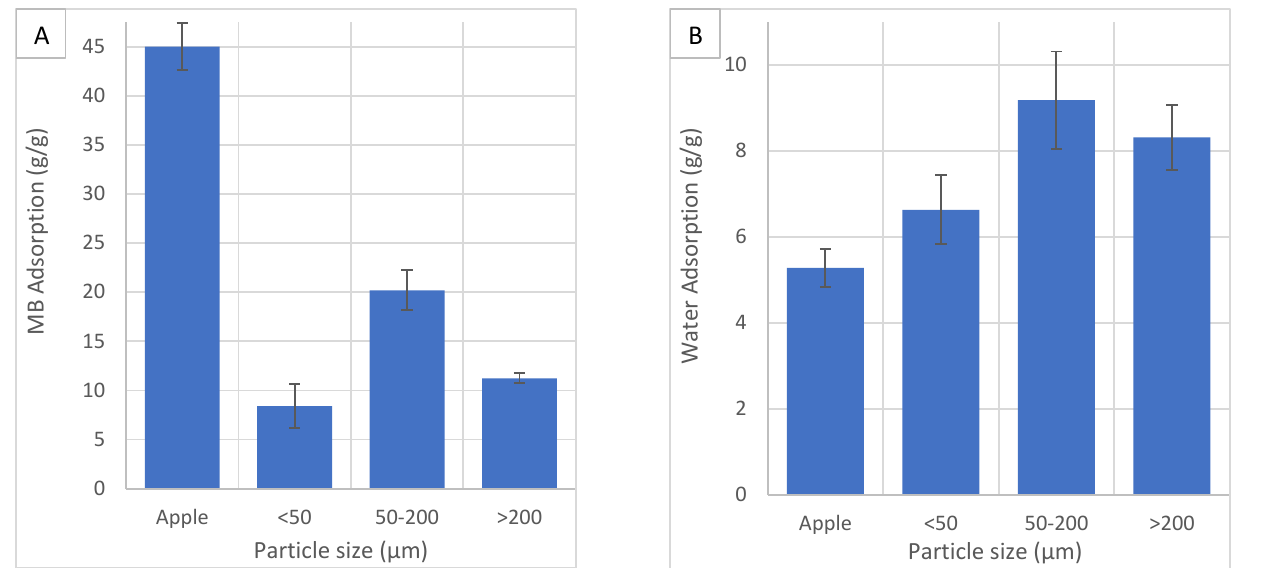
Figure 8. the effect of particle size on ( A ) MB adsorption and ( B ) water adsorption. Figure 8. The effect of particle size on ( A ) MB adsorption and ( B ) water